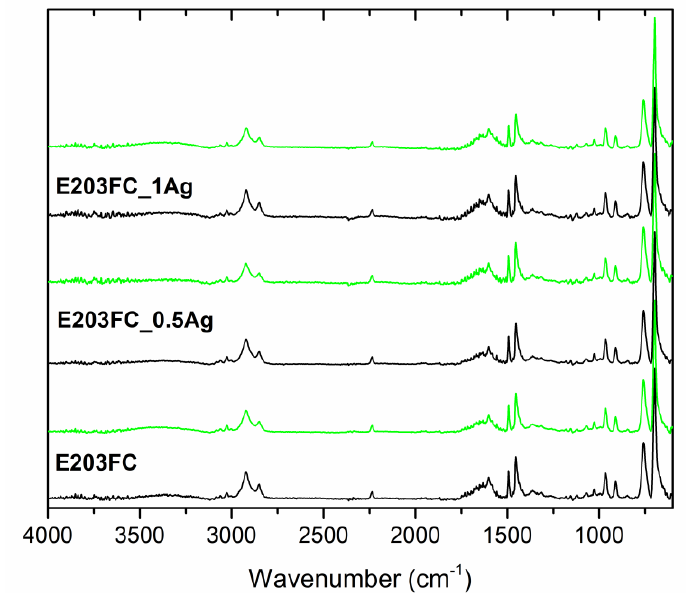
Figure 13. ATR-FTIR spectra of pure polymer (E203FC) and polymer containing 0.5 wt % and 1.0 wt % of silver nanoparticles AgNPs before incubation (black line) and after 24 months of incubation (light green line).